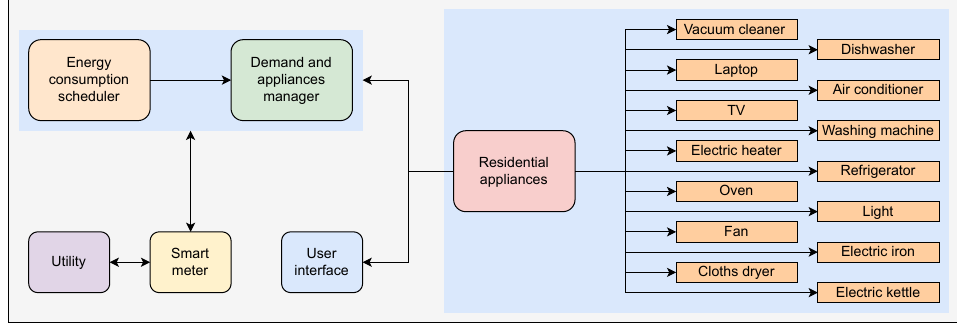
Figure 5. Block diagram for a home energy management